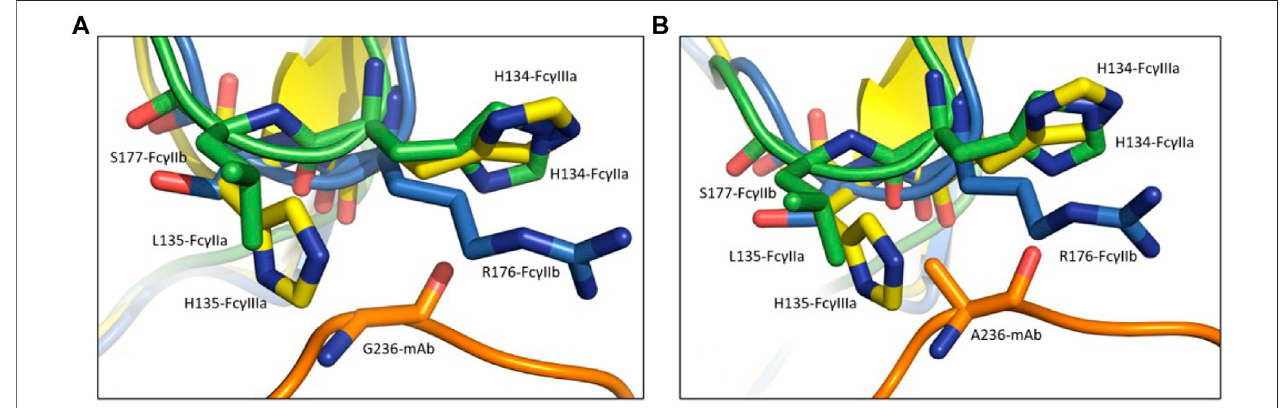
FIGURE 2 | The differences between the Fc γ Rs were exploited to selectively enhance binding of the antibody to the activating Fc γ receptors. The effector substitution G236A isin theFc regionofthe antibody (orange)in thecomplexwiththe inhibitory Fc γ RIIb(blue), and theactivating Fc γ RIIa (green)and Fc γ RIIIa (yellow). In comparison to the wild-type Gly236 (A) , the substituted Ala236 (B) is bulkier thus preventing the binding of the antibody to the Fc γ RIIb due to the steric clash with Arg176, while allowing the binding to Fc γ RIIa and Fc γ RIIIa that have histidines at this